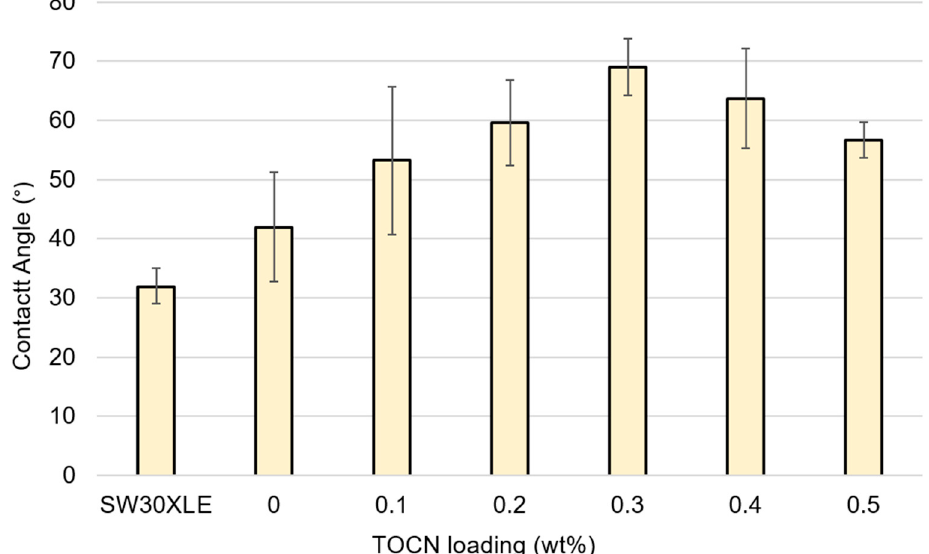
Figure A7. Contact angle measurements for TFN membranes with TOCN loading levels from 0 to 0.5 wt%. For comparison, measurements from a DOW SW30XLE industrial membrane are included.